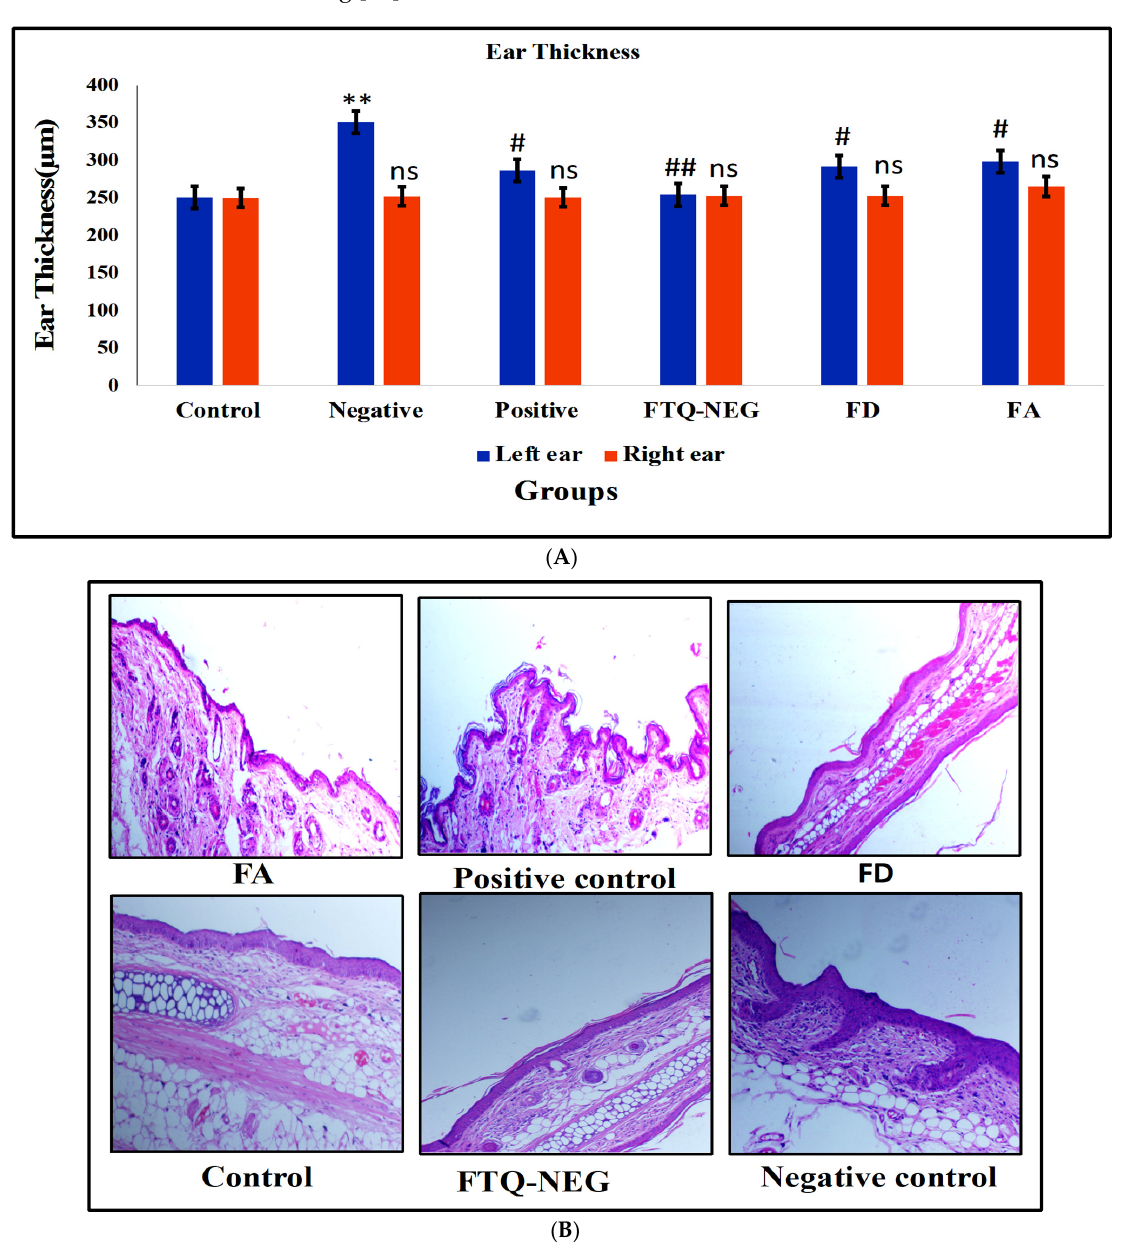
Figure 7. ( A ) Evaluation of ear thickness of all the groups. Data are expressed as mean ± SD. Ear thickness was increased in the negative control group in the left ear (** p < 0.01, control group vs negative control for left ear thickness) and decreased in the positive control, FTQ-NEG, FDG, and FA groups compare to the negative control ( # p < 0.05), ## p < 0.01 vs negative control) in the left ear and non-significant ( ns p (cid:3408) 0.05 vs control) in the right ear. ( B ) histopathology of the left and right ear of mouse skin of all the groups: Control, Negative control, Positive control, FTQ-NEG, FD, and FA Bodyweight and PASI Scoring During the eight-day treatment period, the body weights of all the groups were meas- ured. Until the third day of the trial, all groups except the control group had little decrease in body weight; after that, there was no change in body weight as described in (Figure 8A). The PASI score is one of the metrics used to assess the effectiveness of a product. It is plotted on a scale of 0–4 on day zero, three, five, and eight. The degree of vasodilation caused by the production of cytokines (TNF- α and IL-6) and various substances such as NO, histamine, phospholipase A2 metabolites, and other compounds in the dermis by dendritic cells, mast cells, keratinocytes, and other cells is referred to as erythema. Pro- inflammatory cytokines cause keratinocytes to proliferate, resulting in increased skin thickness. Scaling arises due to the lack of differentiation in keratinocytes. On the eighth day of IMQ treatment, the negative control (disease-induced group) showed scaling, thickness, and erythema with a marking of 3–4,which falls in the severe category, indicat- ing that inflammatory responses have formed, in contrast with the control group [39]. In opposition to the negative control group, the positive control group (Marketed formula- tion), FD in gel and FTQ-NEG exhibited a substantial reduction in erythema, skin thick- ness, and scaling (Figure 8B–D).